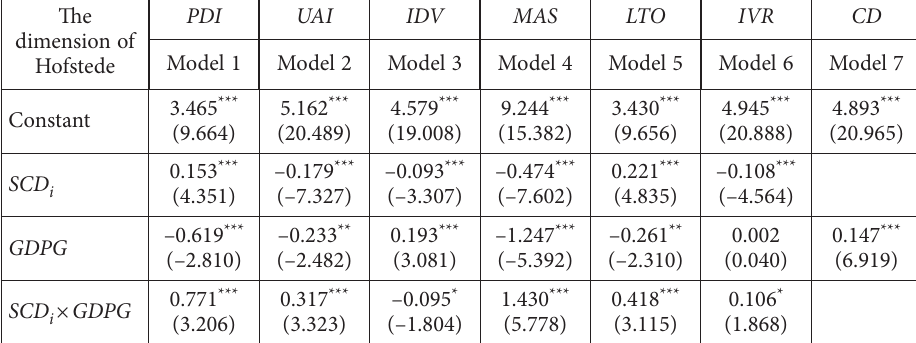
Table 5. Results of the additional analysis with the moderating effect (source: authors’ calculation) The PDI UAI dimension of Hofstede